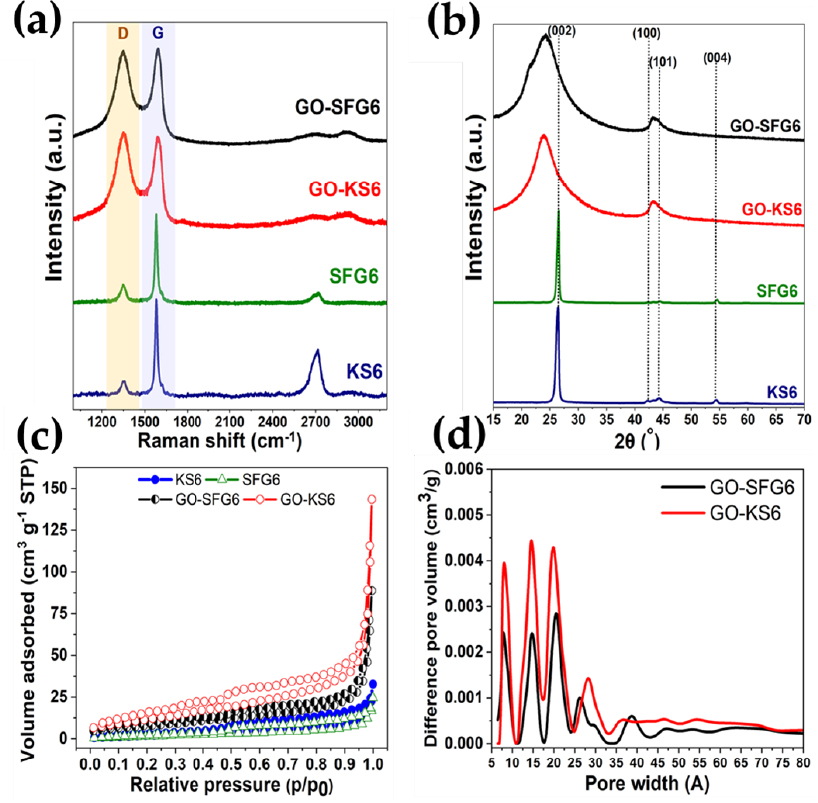
Figure 1. ( a ) The Raman spectra, ( b ) the X-ray diffraction patterns, ( c ) the N 2 adsorption isotherms, and ( d ) the pore size distribution obtained from all GOs prepared and from both graphite precursors. Table 1. The structural parameters of the graphite precursors and the prepared GOs.